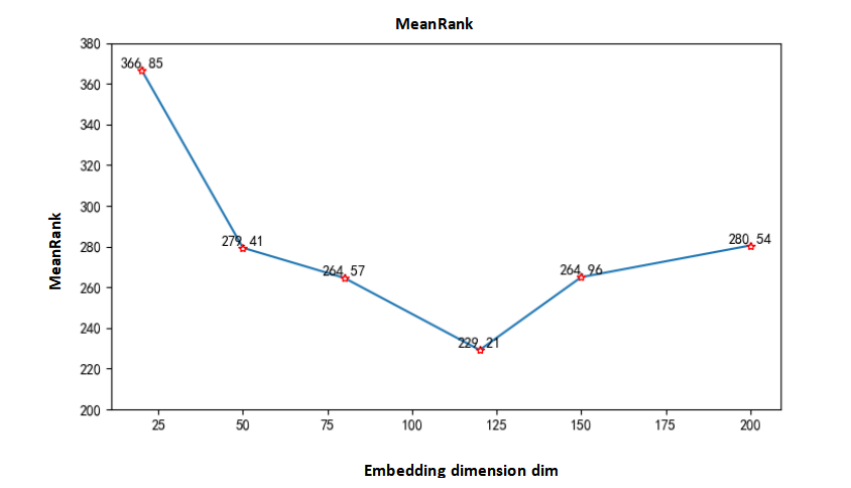
Figure 11. MeanRank values under different embedding